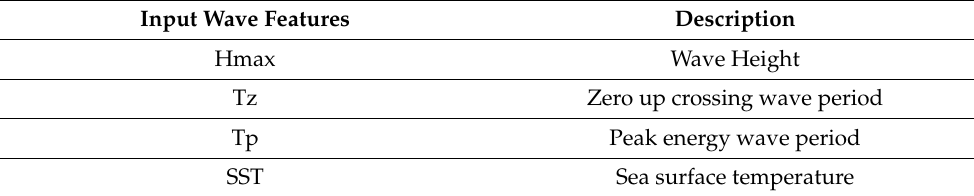
Table 4. Input features and